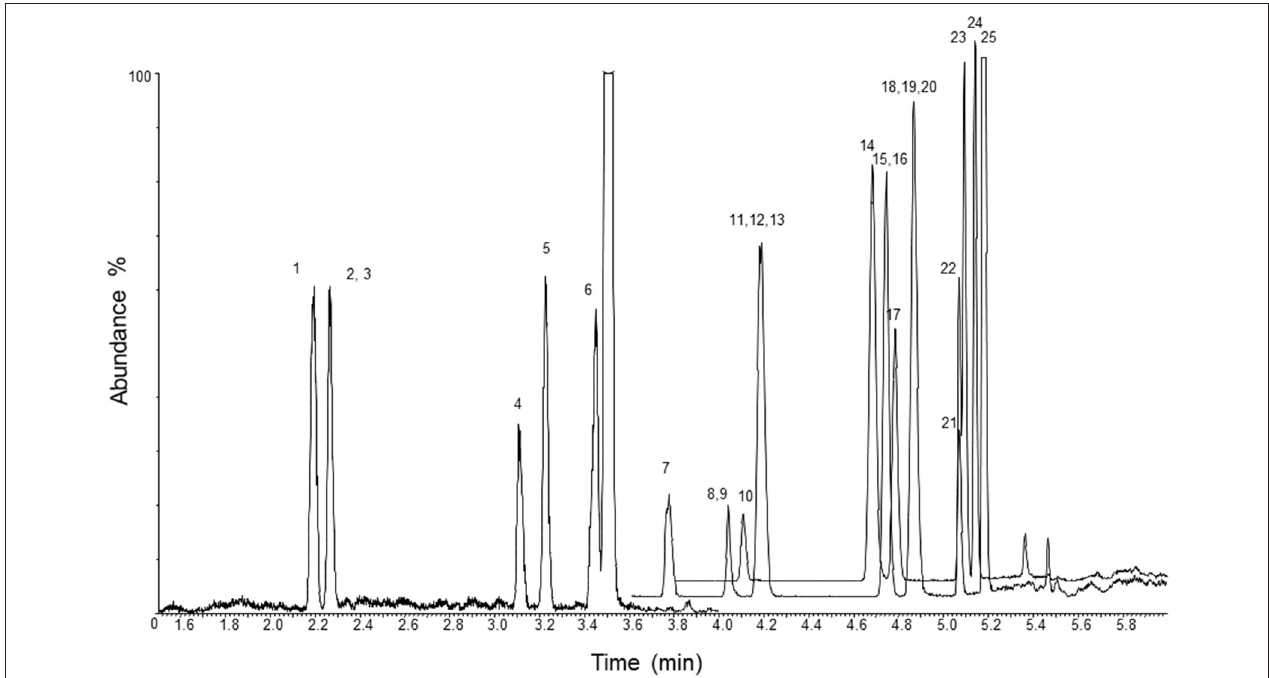
FIGURE 1 | LC-MS/MS chromatogram of a whole blood sample fortified with the analytes at the limit of quantification and their ISs. 1, methoxyacetyl norfentanyl; 2, acetyl norfentanyl; 3, acetyl norfentanyl-D5; 4, norfentanyl; 5, furanyl norfentanyl; 6, cyclopropyl norfentanyl; 7, butyryl norfentanyl; 8, butyrylfentanyl carboxy metabolite; 9, methoxyacetylfentanyl; 10, β -hydroxythiofentanyl; 11, valerylfentanyl carboxy metabolite; 12, furanylethyl fentanyl; 13, acetylfentanyl; 14, fentanyl; 15, fentanyl-D5; 16, despropionylfentanyl (4-ANPP); 17, alfentanil; 18, furanylfentanyl; 19, despropionyl para -fluorofentanyl; 20, cyclopropylfentanyl; 21, carfentanil; 22, butyrylfentanyl; 23, sufentanil; 24, β -hydroxyfentanyl; 25, phenylacetyl